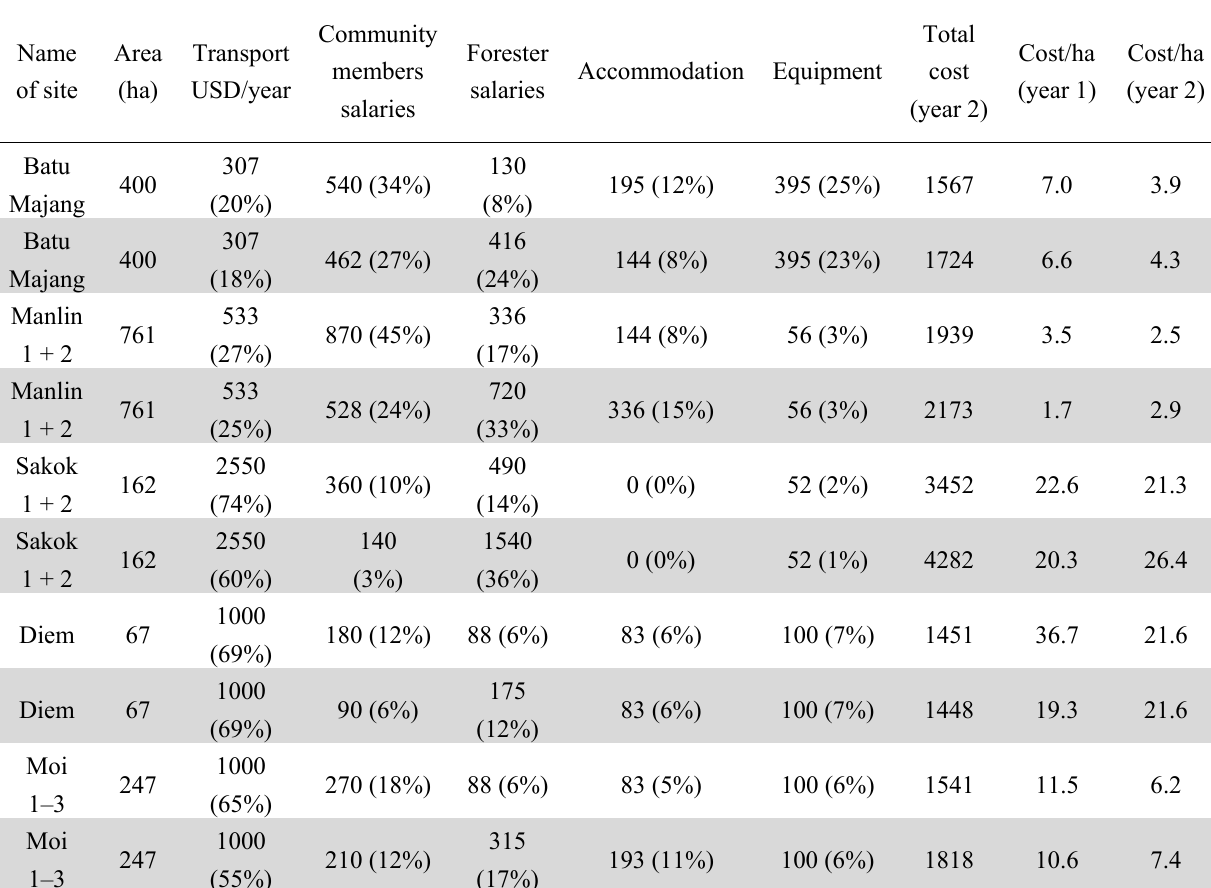
Table 2. Cost of community (white) and professional forester (grey) surveys of biomass (AGB) in the five sites; breakdown of costs is provided for measurements year 2; the cost per plot is provided for year 1 (found in Danielsen et al. (2013) [37]) and year 2; all costs are in